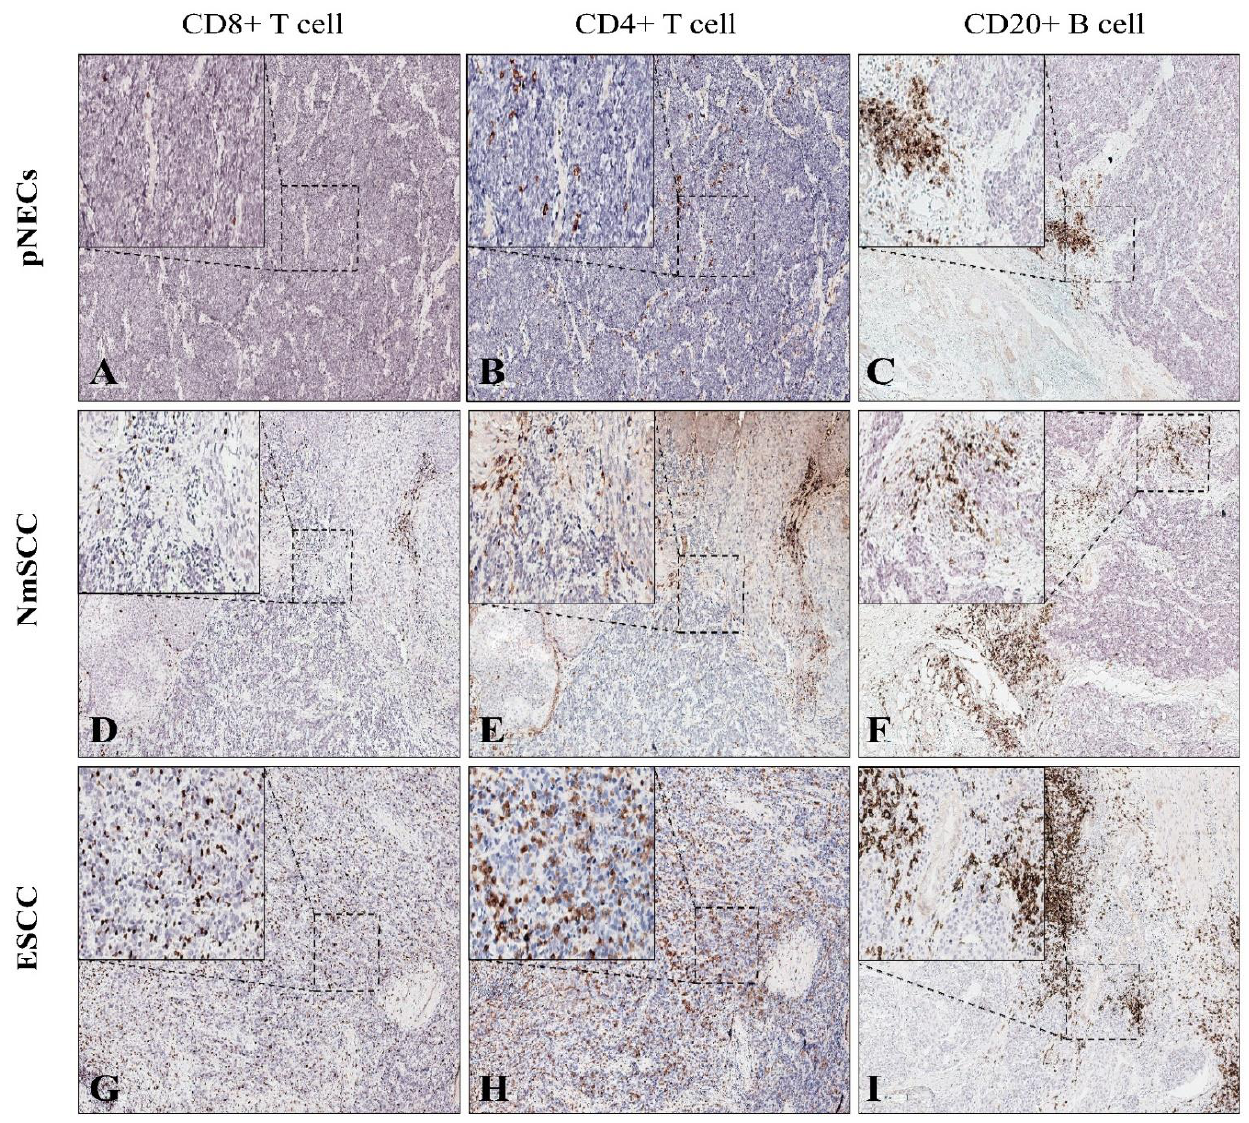
Figure 8. Identification of TILs using immunohistochemical staining under a 400 × high-power field: detection of CD4 + T, CD8 + T, and CD20 + B cells in the ( A – C ) pNECs subgroup; ( D – F ) NmSCC subgroup; and ( G – I ) ESCC group. Abbreviations: pNECs, pure neuroendocrine carcinomas; NmSCC, neuroendocrine neoplasms mixed with squamous cell carcinoma; ESCC, esophageal squamous cell carcinoma; TILs, tumor-infiltrating lymphocytes.